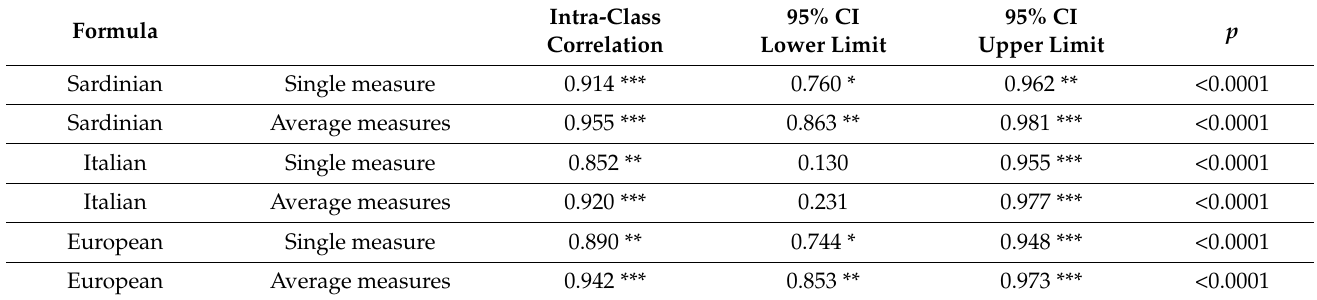
Table 3. ICC values according to the comparison between the real and estimated age, using the Sardinian, Italian and European formula, respectively (* = acceptable agree; ** = optimal agree; *** excellent agree).